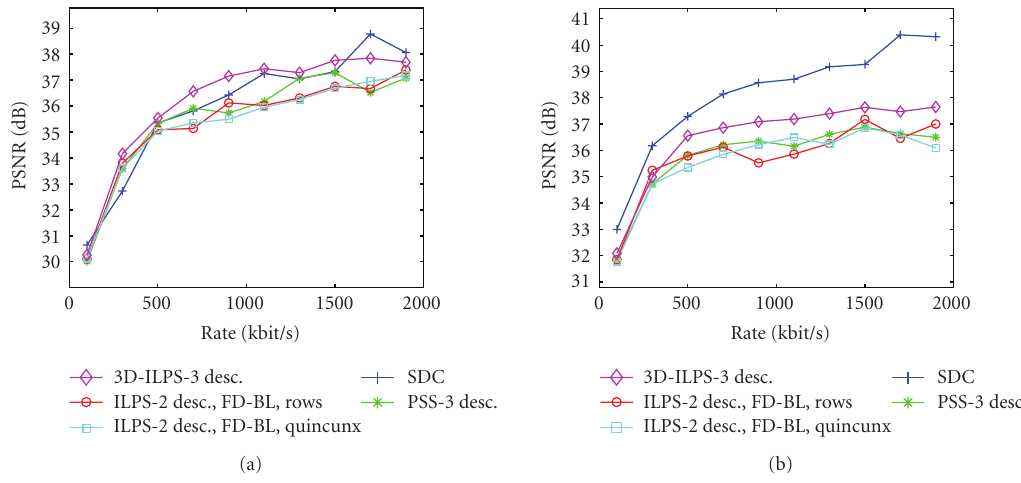
Figure 17: Performance of left view, three subsequences received, 10% packet loss. (a) Breakdance. (b) Ballet.